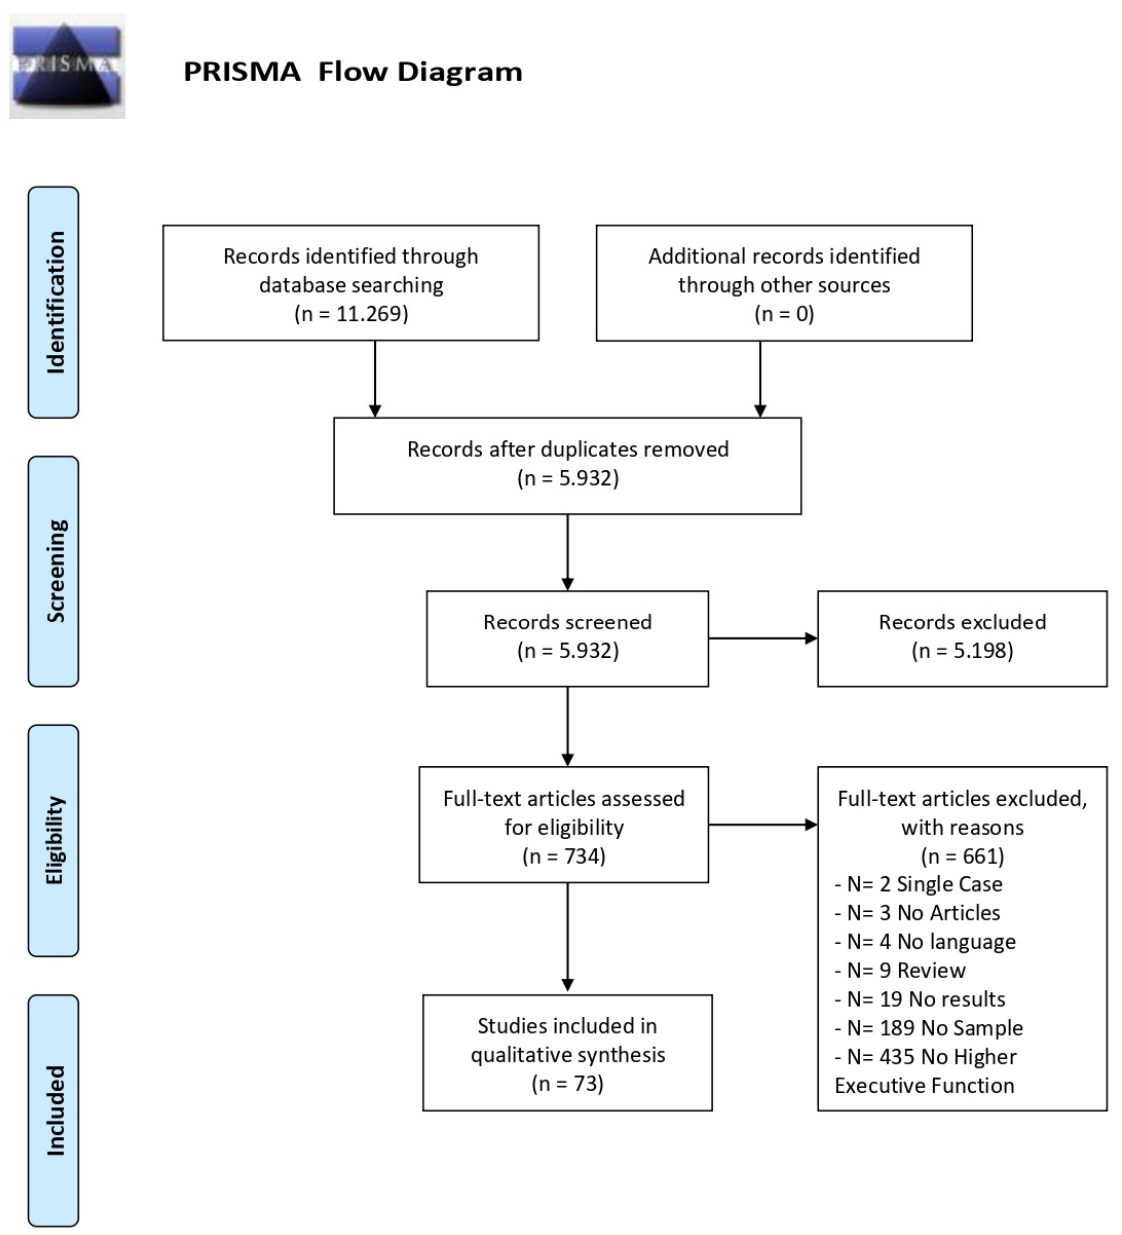
Figure 1. Flow diagram, PRISMA Statement [24,25].